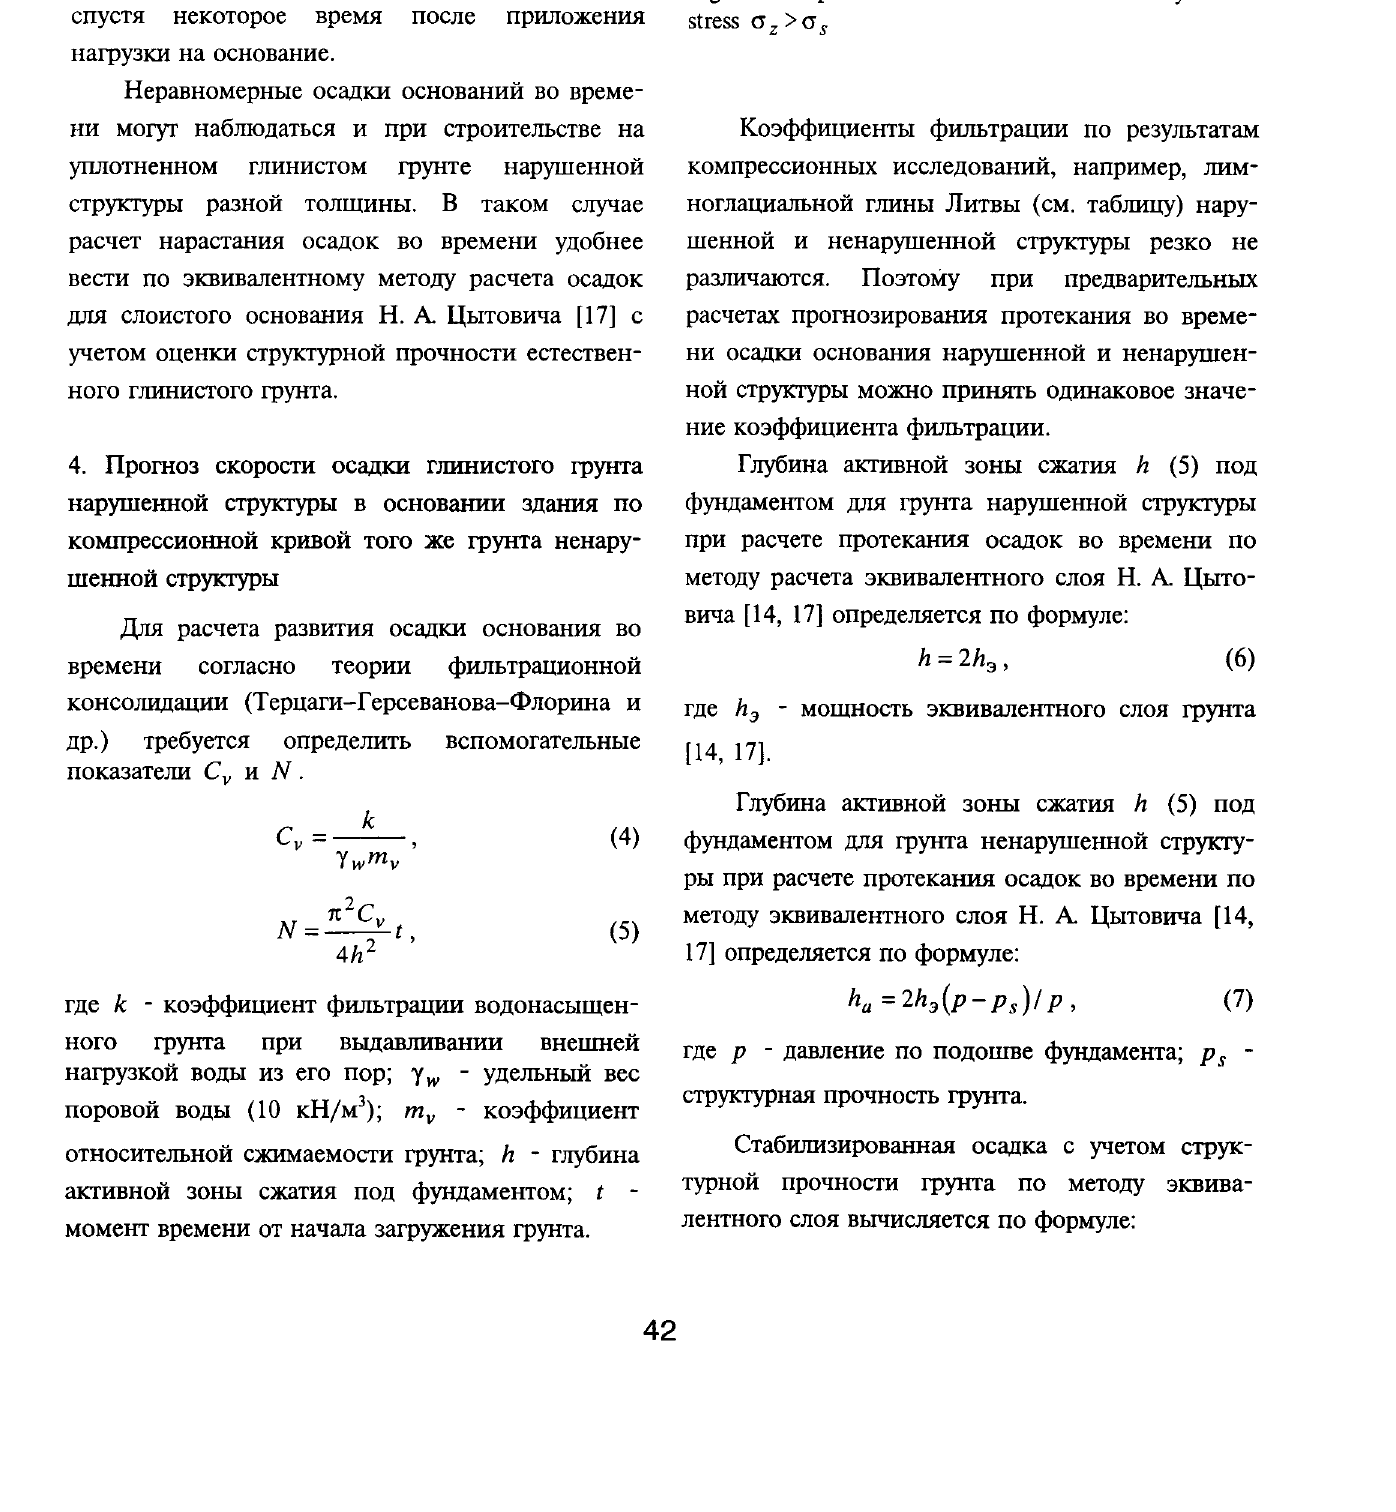
Fig 5. Compression zone of undisturbed clay under stress <J z > <J